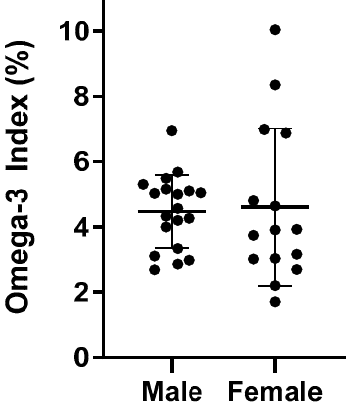
Figure 2. Individual O3I scores in males ( n = 19) and females ( n = 15). Table 3. O3I category based on reported supplementation status and sex.